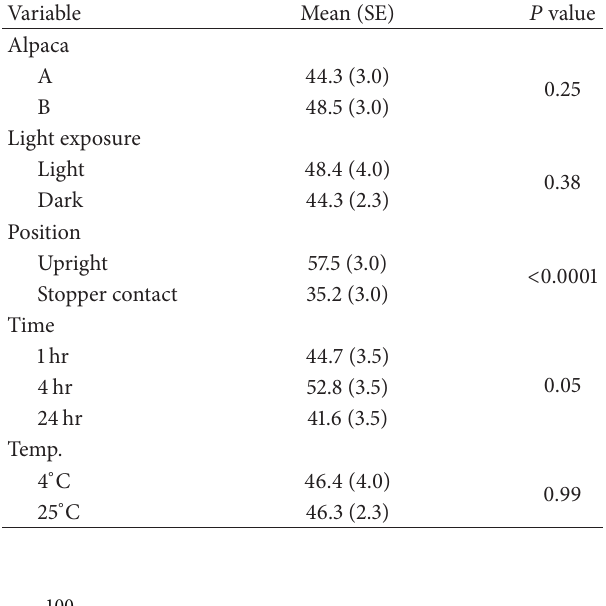
Table 2: Least squares means serum cholesterol concentrations ( 𝜇 g/dL) in 2 adult male alpacas after exposure of whole blood